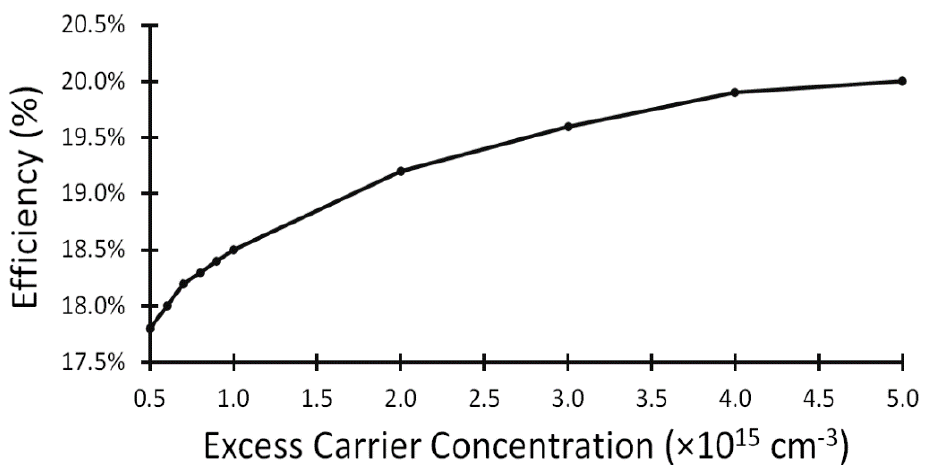
Figure 6. Excess carrier concentration as a function of the PCE for the proposed solar cell structure. The open-circuit voltage, FF , and PCE are illustrated in Table 3 for different excess carrier concentrations. Table 3. Open-circuit voltage, FF , and overall efficiency for the proposed structure. Excess Carrier